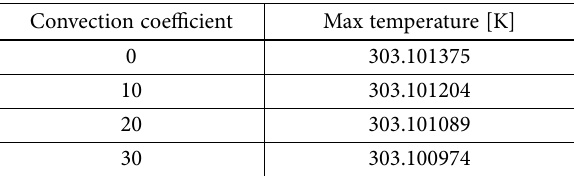
Table 11. Resultant beam temperature after train and environmental